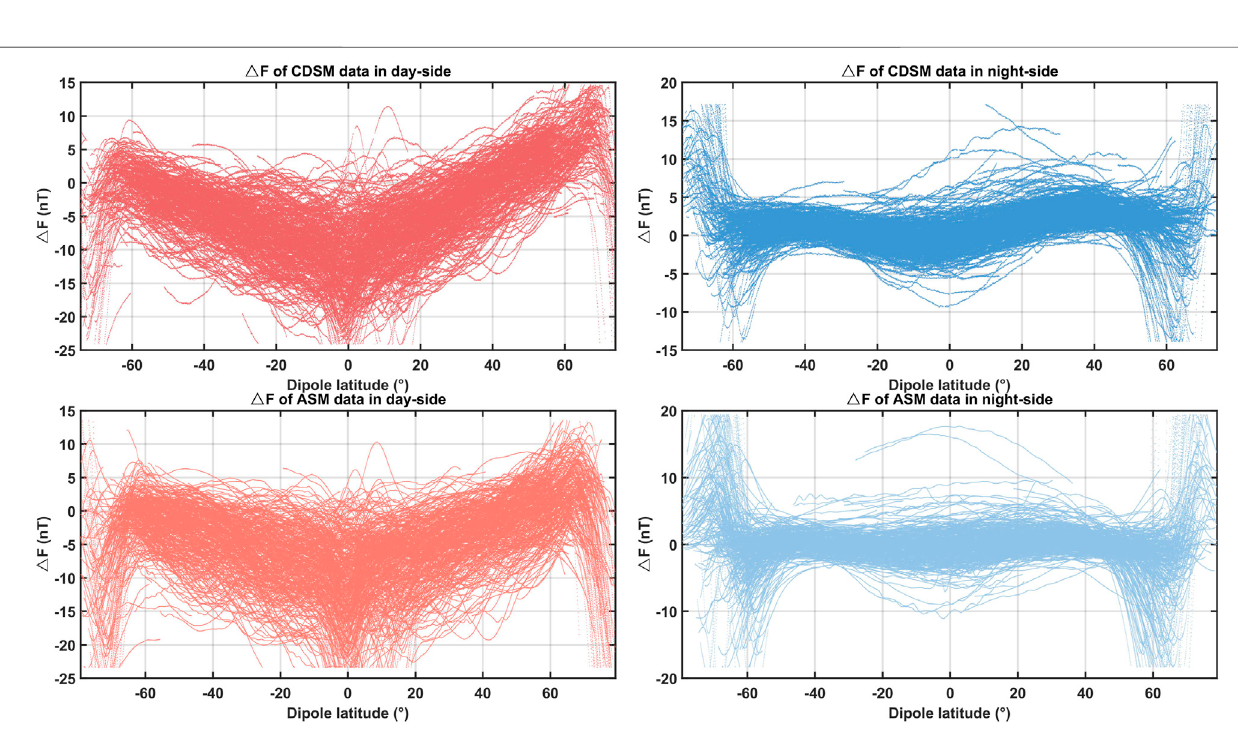
Frontiers in Earth Science |